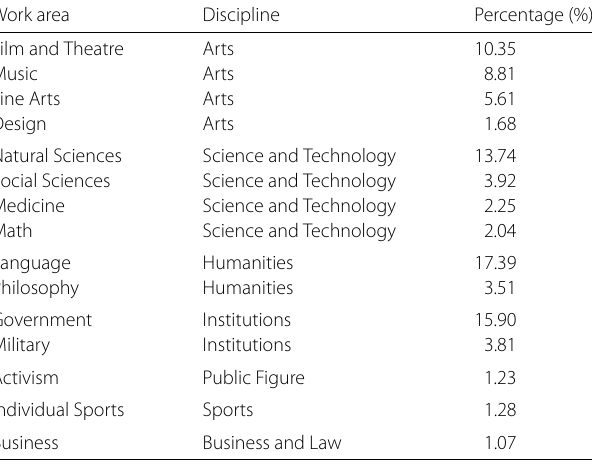
Table 1 Composition of the selected subset of notable people, organized by the different work areas and disciplines present in the Pantheon dataset [19]. In particular, 15 work areas are presented, sorted by